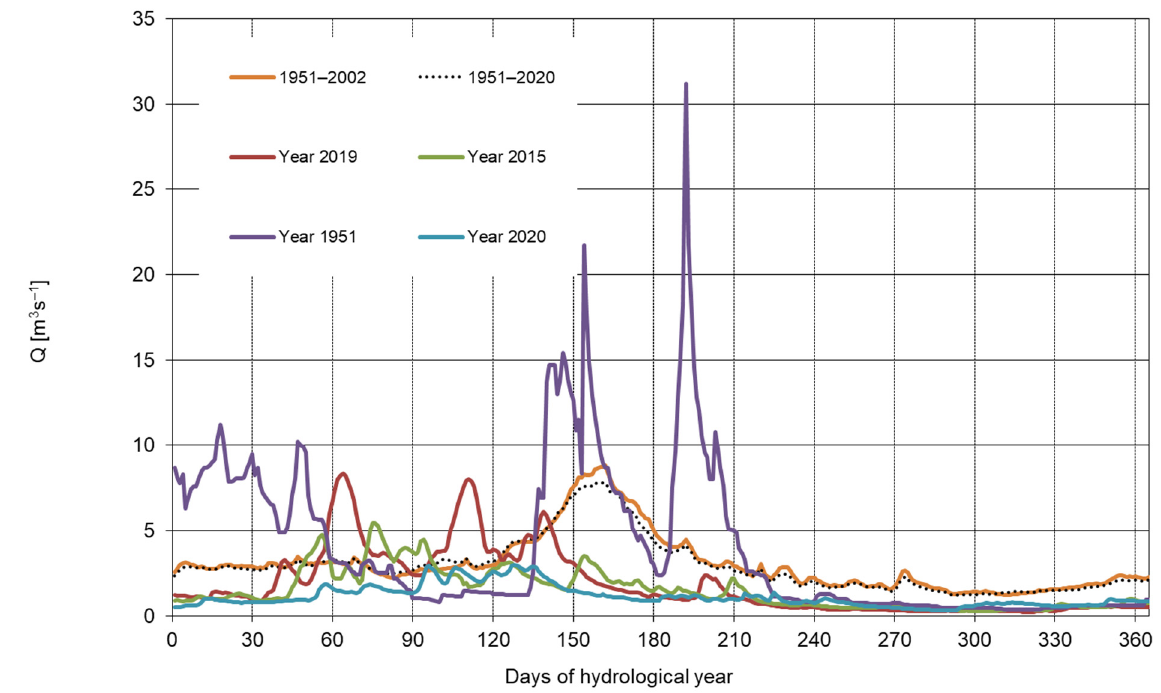
Figure 19. Hydrographs of 2020, 2019, 2015, and 1951 compared to daily flows over the periods of 1951–2002 and 1951–2020 in the Narewka at the Narewka gauging station.